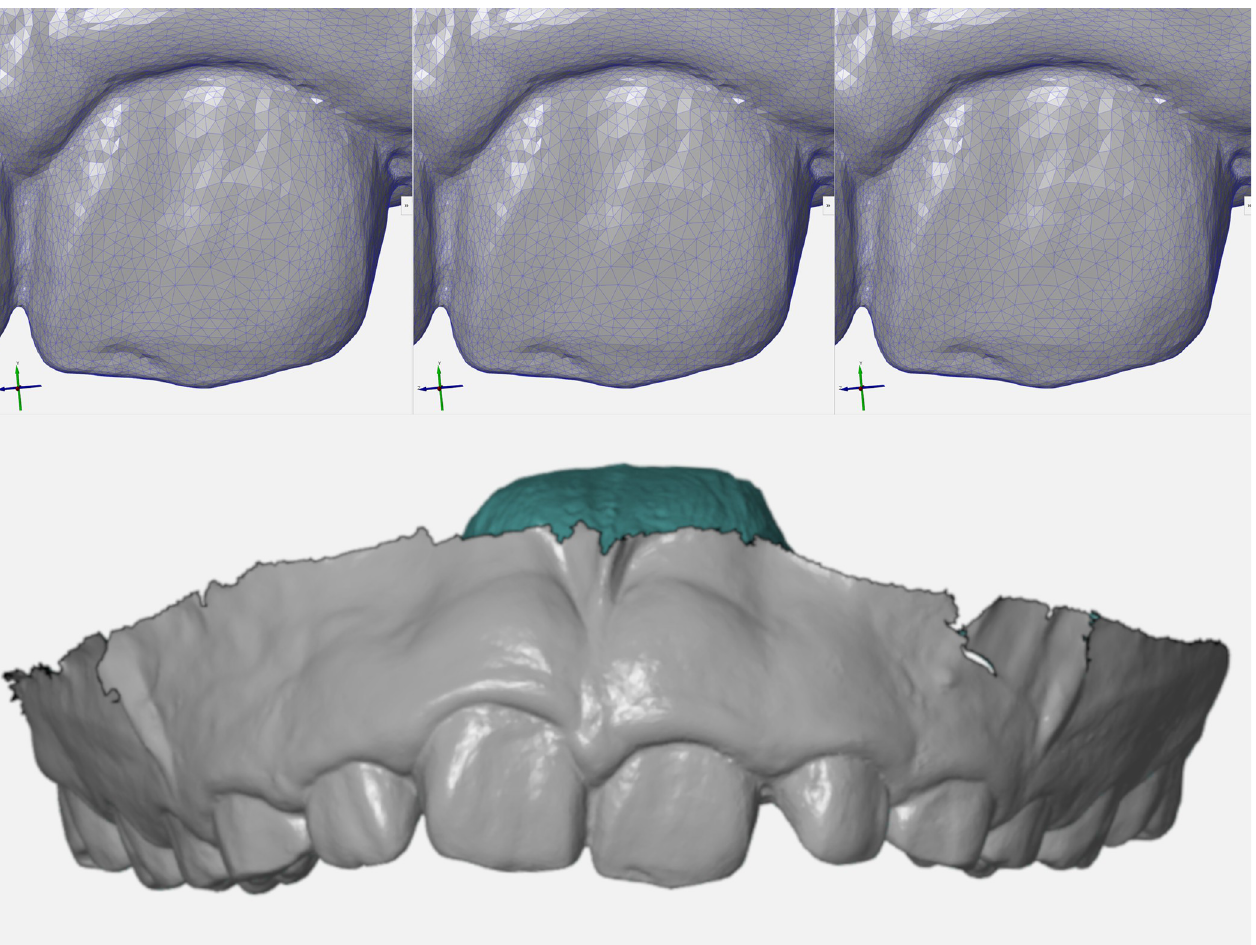
Fig 1. Comparative visualization of 3D models’ wireframe and superimposition for the permanent dentition. Original (A), decompressed/transferred (B), and superimposed (C) dental models in “zoom-in” visualization to enable the observation of object triangles (wireframe). An overview of the superimposed and pair-wise compared 3D dental models is provided (D) to show that no dimensional changes were detected in the permanent dentition.